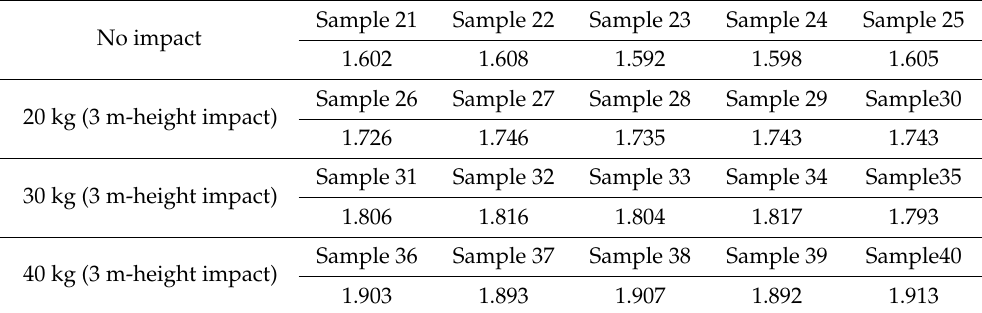
Table 4. The fractal dimensions of concrete samples after burning (center of the arch).